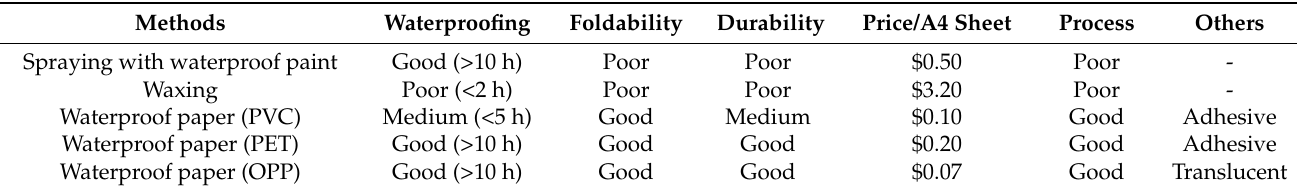
Table 1. Comparison of waterproof materials and